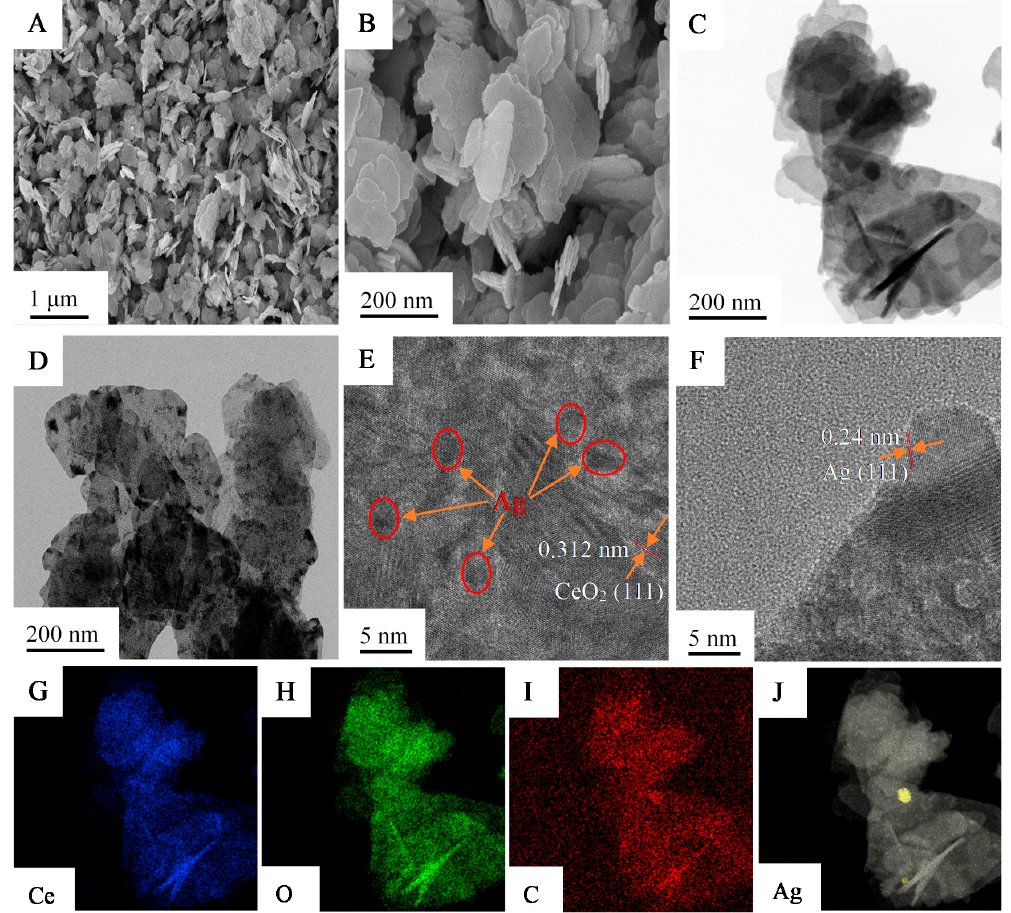
Figure 3. SEM images ( A , B ), TEM images ( C , D ), high-resolution TEM (HRTEM) images ( E , F ), and elemental mapping images ( G – J ) of 3-Ag/CeO 2